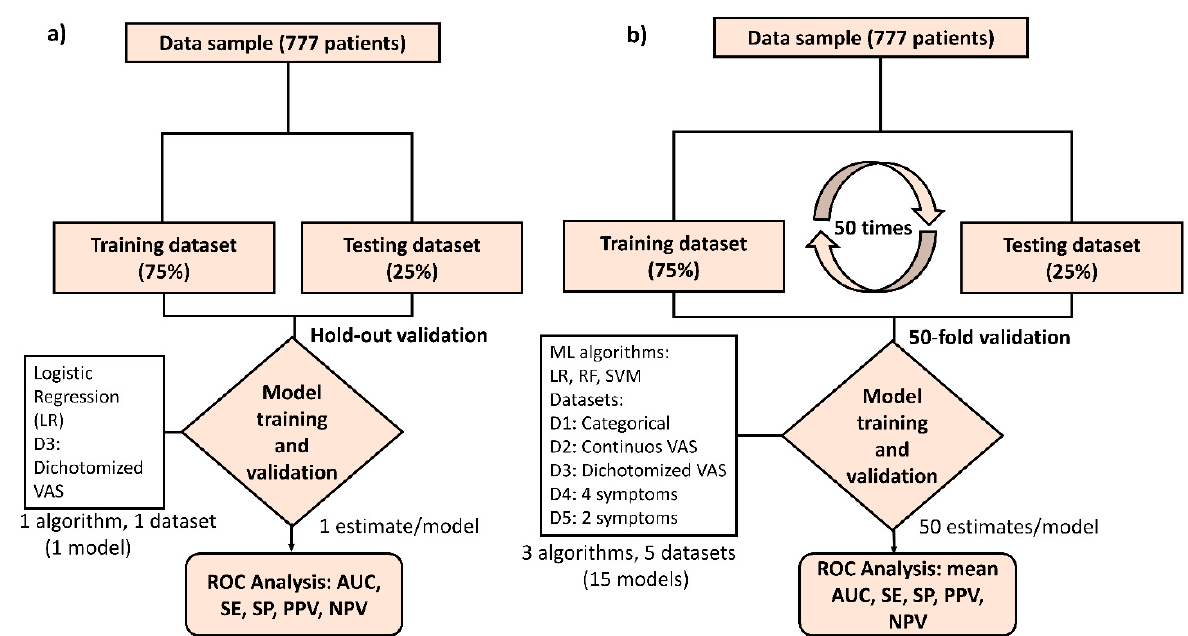
Figure 1. Modelling framework for the analysis of symptom associations and COVID-19 prediction. Data from 777 patients were obtained from different hospitals in the South of Spain. ( a ) For the analysis of the association between the intensity reported for loss of smell and taste, along with other symptoms, and a COVID-19 diagnosis, a first model was derived using step-wise logistic regression (LR) with a holdout validation scheme, by splitting the sample into a training (75%) and a testing dataset (25%). The performance of the model was assessed through ROC analysis, with AUC, SE, PPV and NPV parameters being calculated for the holdout testing (25%) dataset. ( b ) For the analysis of the discrimination ability and predictive value of different symptom variable datasets, including categorical (D1), continuous visual analog scales VAS (D2), dichotomized VAS (D3) as well as simplified predictor datasets with a reduced number of symptoms (D4 and D5), a comprehensive 50-fold cross-validation scheme was designed by assessing three different ML algorithms (LR, RF, and SVM). The performance of the models obtained were calculated through the mean AUC, SE, SP, PPV and NPV values over the 50-cross validated estimates obtained for each model tested. LR = logistic regression. RF = random forest. SVM = support vector machine, ROC= receiver operating characteristic, AUC= area under the curve, SE = sensitivity, SP = specificity, PPV= positive predictive value, NPV= negative predictive